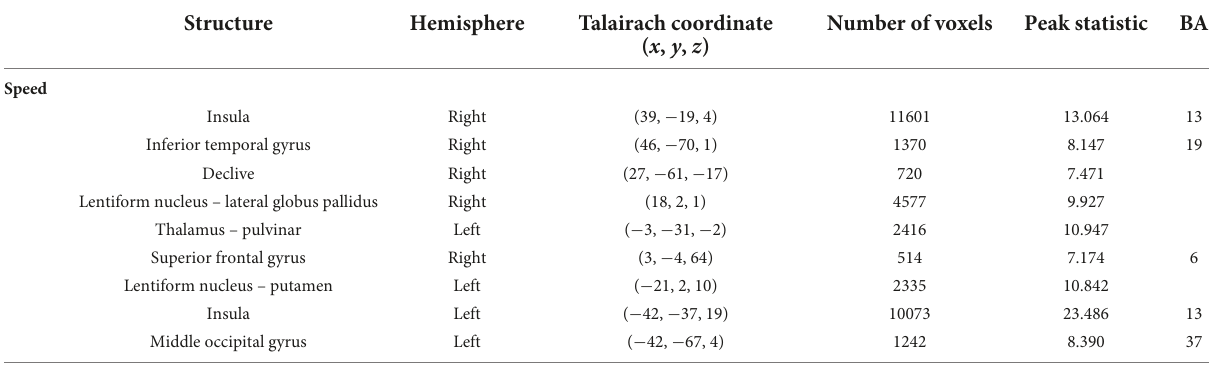
TABLE 4 Results of the visual feature analysis for the median values of